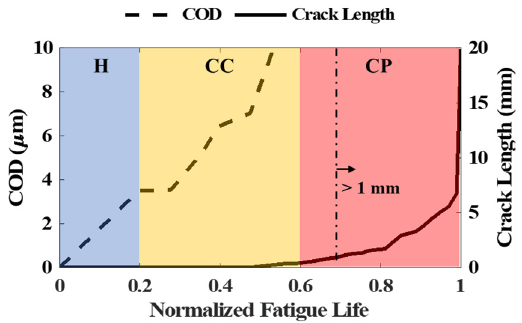
Figure 10. The variation of crack length and COD against the normalized fatigue life divided into three regimes, viz. healthy, crack coalescence (CC), and crack propagation (CP). The bifurcation of the CP regime beyond the crack length of 1 mm indicated by CP > 1 mm is also highlighted. The data obtained from the U-notched specimens is similar and is excluded for brevity.